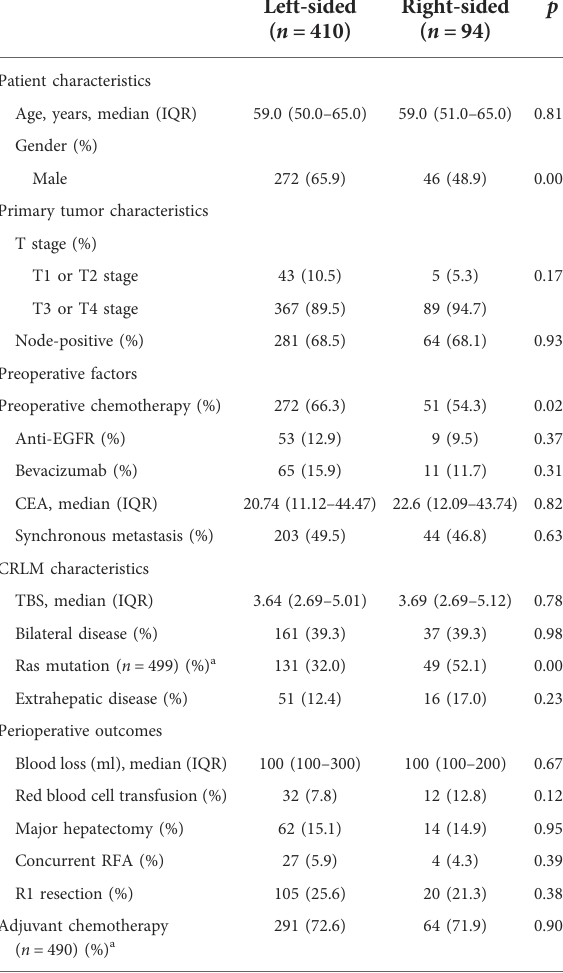
TABLE 3 Univariate and multivariate survival analyses in patients of TBS <7.